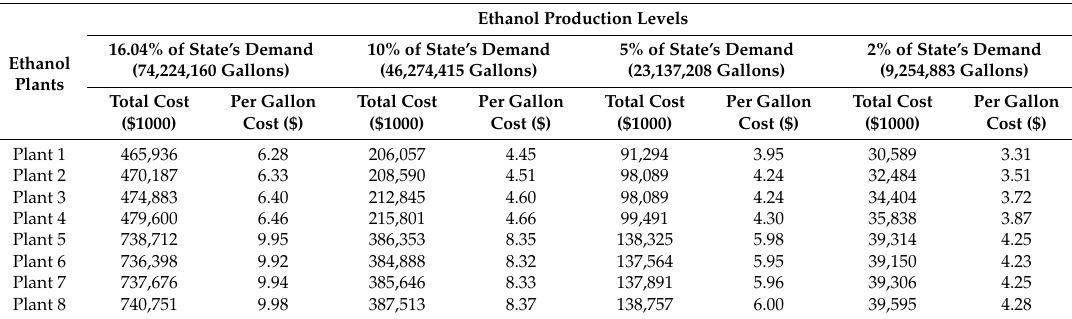
Table 4. Estimated cost of ethanol production for different ethanol production levels.